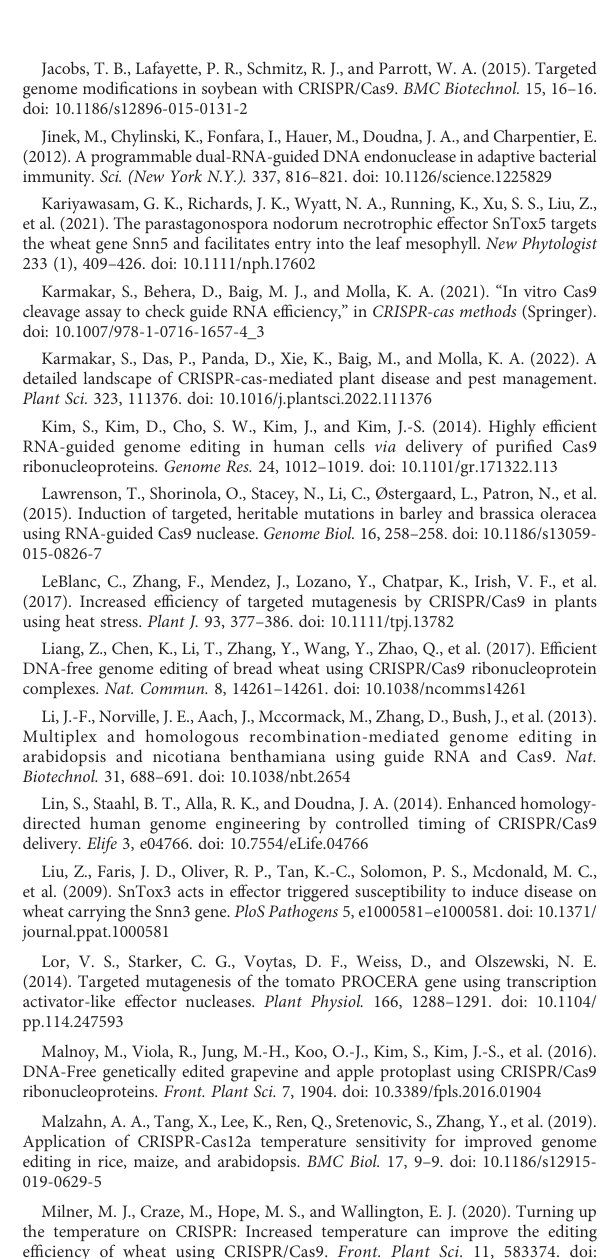
SUPPLEMENTARY FIGURE 2 Exampleofthedifferenceinthenumberofuniquemutantallelesbetween 14 dpb and 48 dpb. Provided are the detected alleles in immature embryos bombarded with Tsn1g2-Cas9 RNPs and treated at 37°C. The vertical bold dashed line represents the Cas9 cleavage site. Mutant alleles are marked with *. Wild type alleles are marked as WT. Dashes indicate base pair deletions, red boxes indicate base pair insertions, and bold letters indicate base pair substitutions. SUPPLEMENTARY FIGURE 3 Wheat protoplasts isolated from leaf